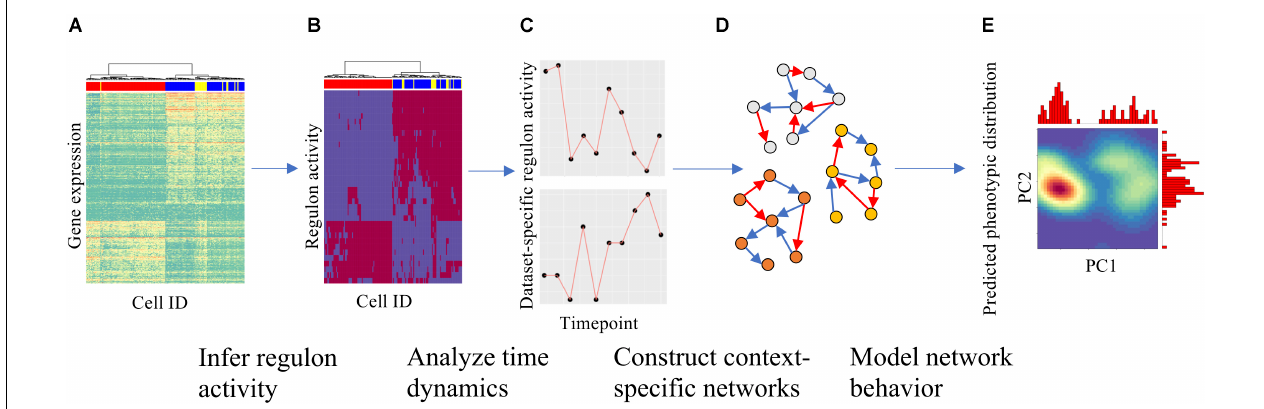
FIGURE 1 | Overall strategy for analyzing scRNA-seq data and constructing context-specific gene regulatory circuits (GRCs). (A) Gene expression heatmap with cells in columns and gene expression levels in rows, clustered hierarchically to group cells. (B) Using gene expression data and SCENIC, gene regulatory module (regulon) activity for each cell could be inferred and is shown in a similar heatmap. (C) The time dynamics of selected regulons were then compared across datasets to identify divergent regulatory trajectories. (D) After the role of each regulon across datasets was characterized, numerous context-specific circuit topologies were generated (nodes represent genes, blue and red arrows represent excitatory and inhibitory regulation, respectively) using different statistical cutoffs for network modeling. (E) Finally, dynamics simulations were performed on each circuit to identify the optimal circuit that captures the terminal cellular states from the experimental datasets. Using simulations, one can also predict the paths of cellular state transitions upon either signal induction or removal. Density maps show PCA on simulation results with marginal